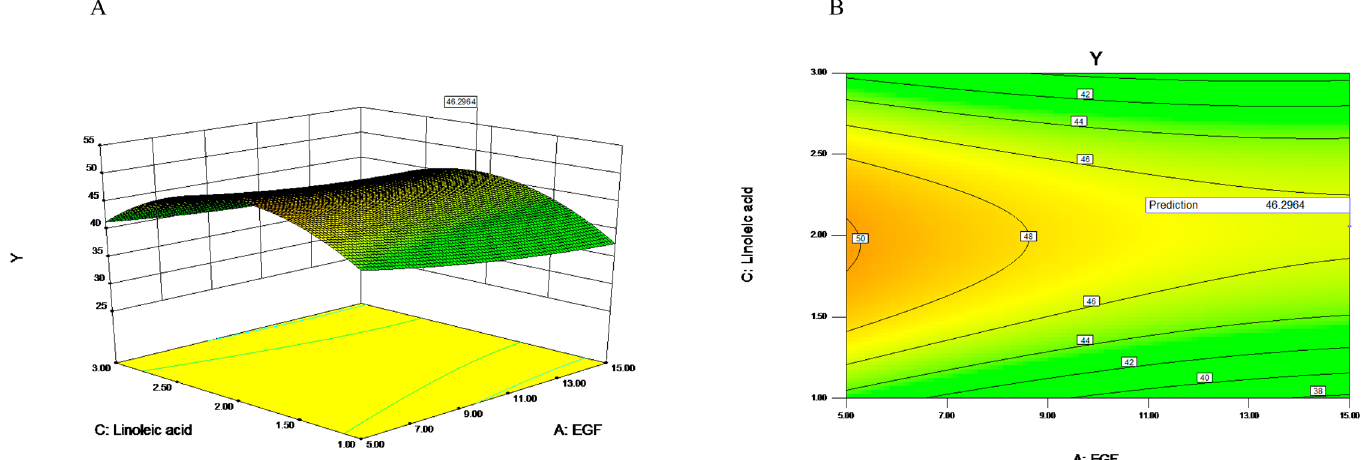
Fig 5. Response surfaceplot of the regression equation (EGF, linoleic acid). The three-dimensionalresponsesurface plots (A) and contour charts (B) were used to illustrate the individualand interactive effects of EGF and linoleicacid.